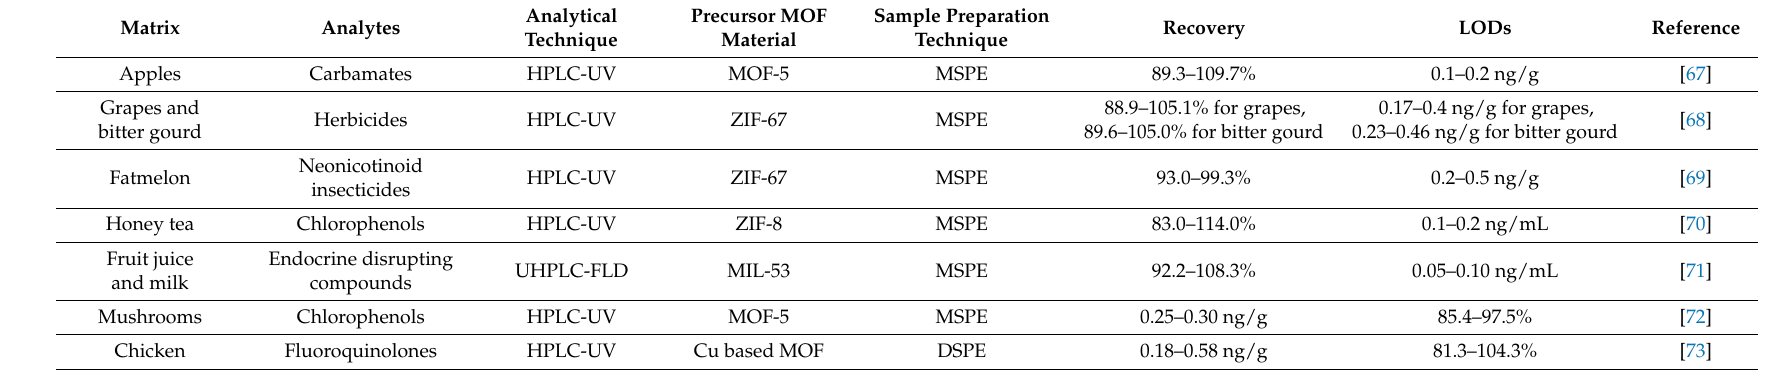
Table 2. Applications of MOF-derived carbons for food sample